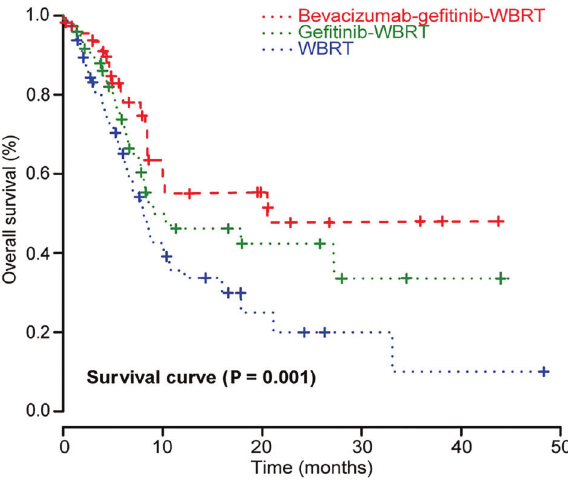
Figure 1. Kaplan-Meier estimation of overall survival rate in patients with brain metastases due to non-small-cell lung cancer treated with bevacizumab-ge fi tinib-WBRT, ge fi tinib-WBRT and WBRT. WBRT: whole brain